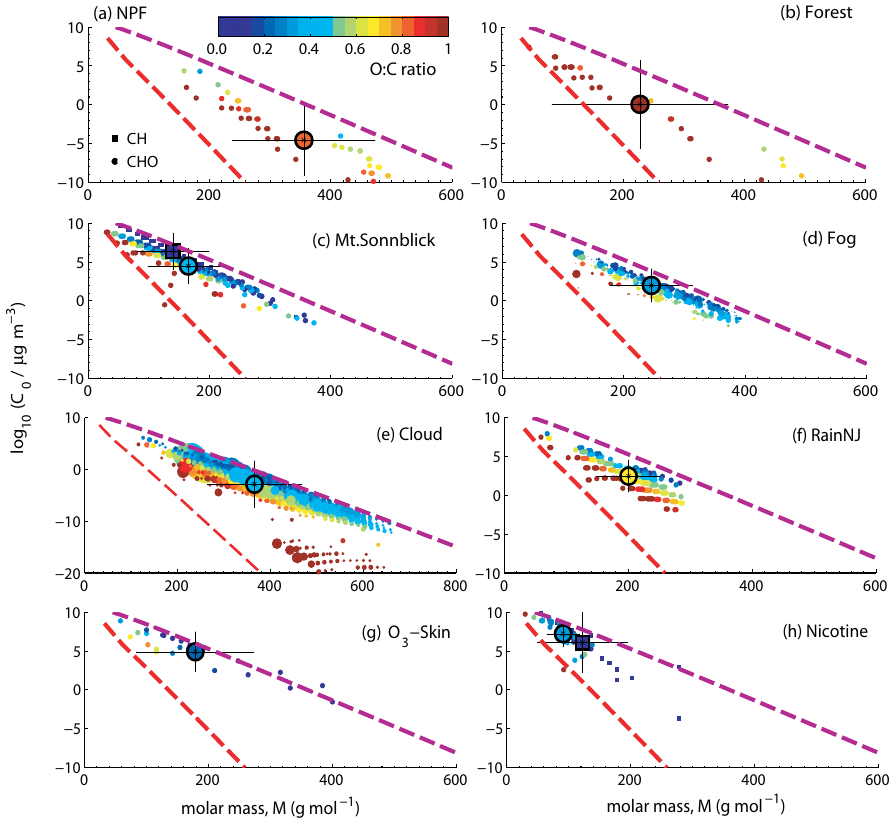
Figure 5. Molecular corridors of saturation mass concentration ( C 0 ) vs. molar mass ( M) for CH and CHO compounds measured in (a) cham- ber experiments for new particle formation (Ehn et al., 2012; Schobesberger et al., 2013), (b) field campaigns conducted in the boreal forest of Hyytiälä (Ehn et al., 2010, 2012), (c) a field campaign conducted at Mt. Sonnblick (Holzinger et al., 2010), and measurements of (d) fog in the city of Fresno (Mazzoleni et al., 2010), (e) clouds at Mt. Werner (Zhao et al., 2013), (f) rain in New Jersey (Altieri et al., 2009a, b), (g) indoor aerosols from human skin lipids and ozone (Wisthaler and Weschler, 2010), and (h) tobacco smoke (Sleiman et al., 2010a, b). The small markers represent individual compounds identified in each data set color-coded by atomic O : C ratio. The size of the small markers in (d) and (e) is linearly scaled by relative intensity of MS signal. The larger symbols with error bars indicate surrogate compounds with the mean values of M , C 0 , and O : C ratio computed for each data